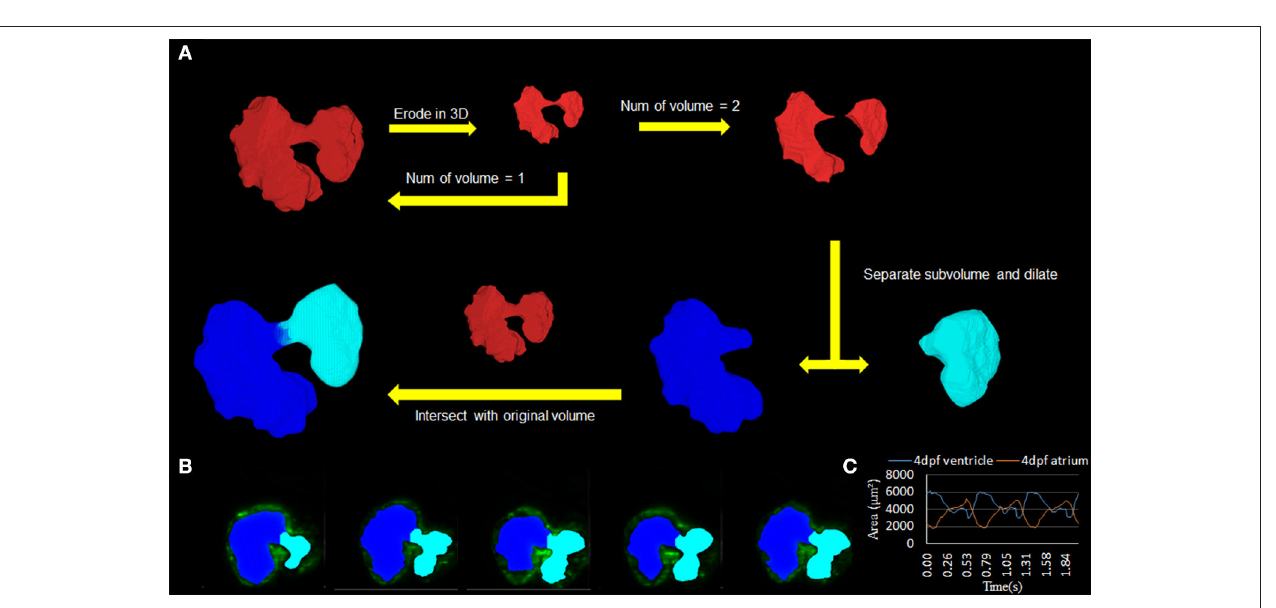
a clear distinction between the two different chamber areas